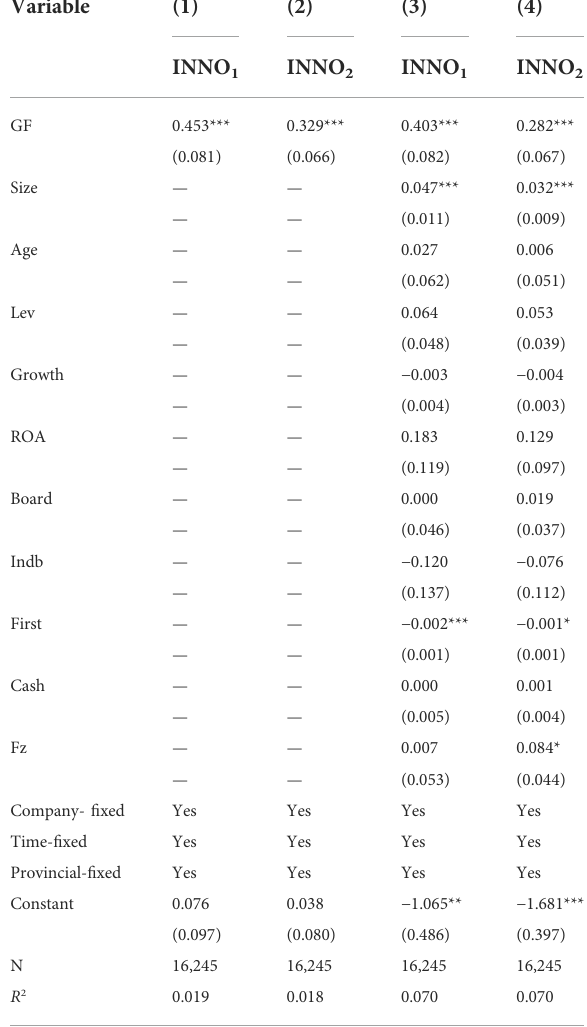
TABLE 3 Analysis of the benchmark model